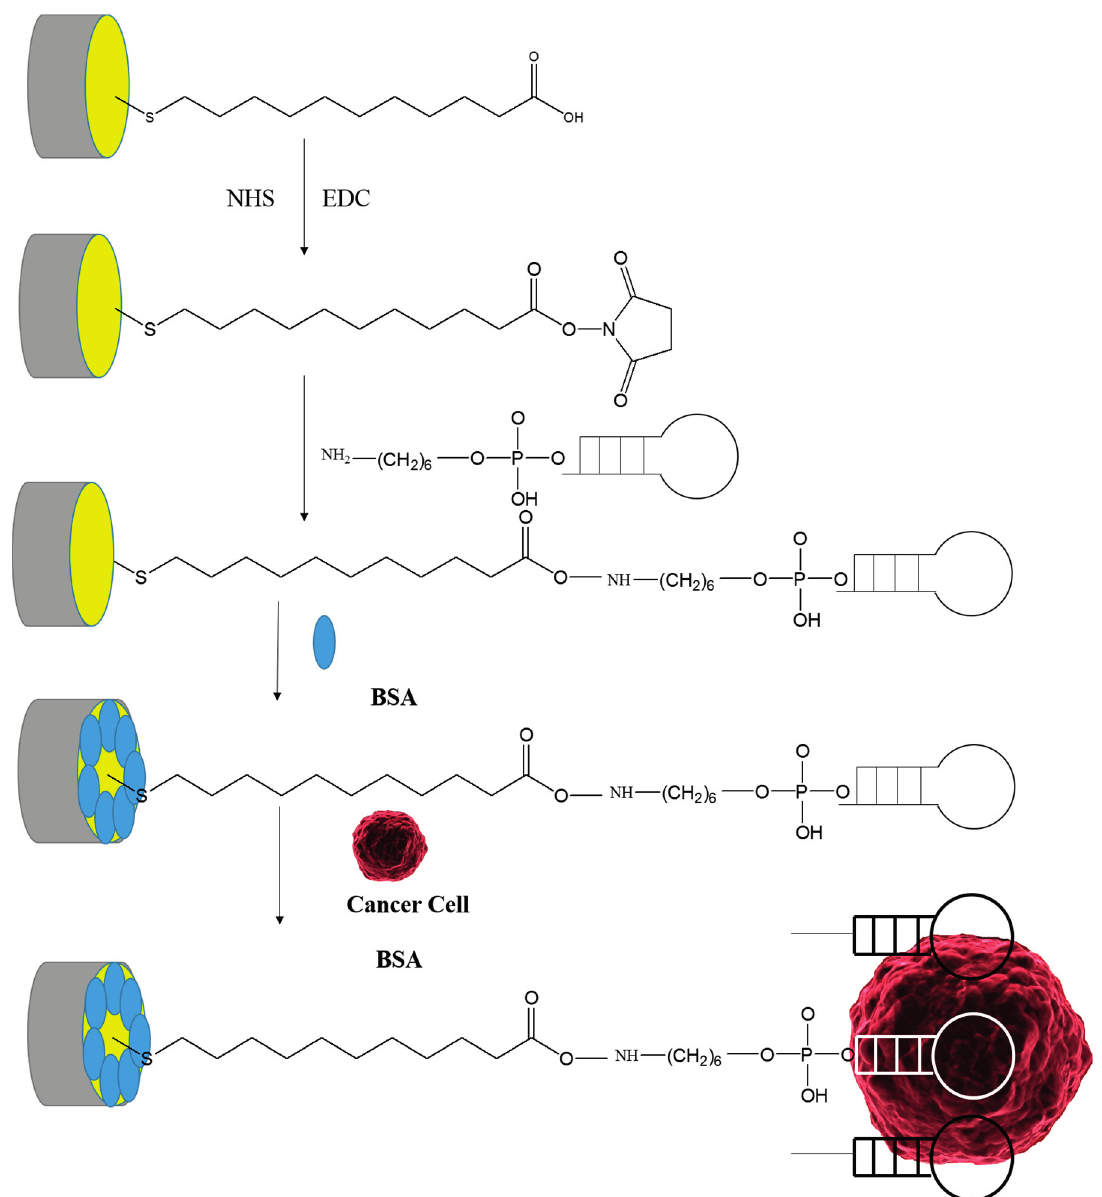
Figure 4. Schematic of the five step chemical process for the functionalization of an Au electrode dedicated for colon cancer